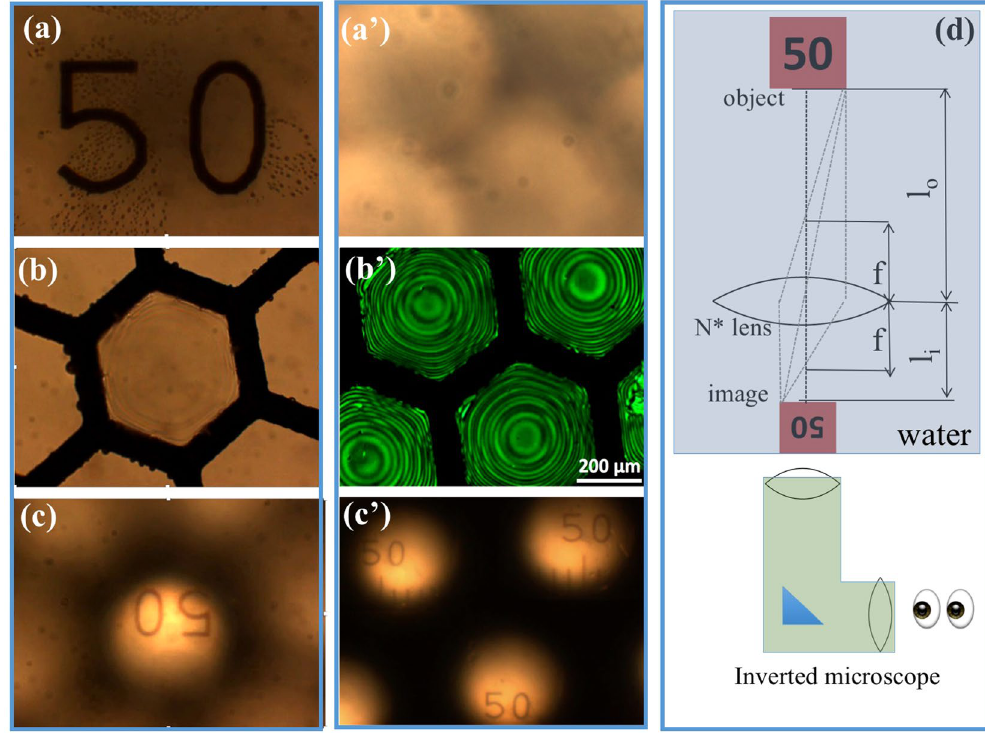
Figure 3. Demonstration of lensing using an N * microlens array. ( a – c ) micrographs seen when only the middle cell is filled with LC and the others are empty; ( a’ – c’ ) micrographs when every grid cells are filled with LC. ( a ) Direct image of a “50” marking on a microscope calibration slide, using light that travels through the empty cells. ( b ) Direct image of the N * microlens surrounded by empty cells. ( c ) Inverted image of the marking produced by N * microlens, using circular polarizer. ( a’ ) “Image” seen at the equivalent position to ( a ), with all the grid cells filled with microlenses. ( b’ ) Direct image of the array of microlenses as seen using a pair of circular polarizers and green filter. ( c’ ) Array of inverted images of the marking produced by the N * microlens array, using circular polarizers. ( d ) Illustration of the geometric optics and the imaging setup for a single microlens, with the relevant parameters. Blue parts illustrate water medium, white part at the bottom illustrates the inverted microscope used to focus on the object, grid and image by changing the position of the objective. The different components are not to